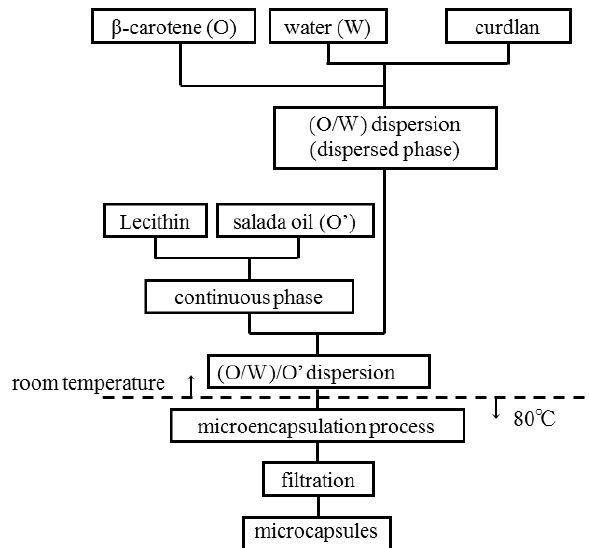
Figure 3. Flow chart for preparing microcapsules.